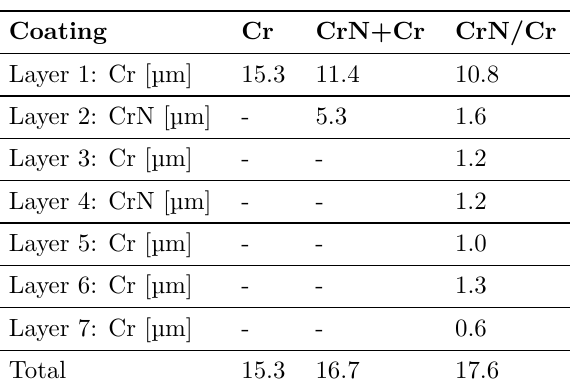
Table 1. Measured thicknesses of studied coatings